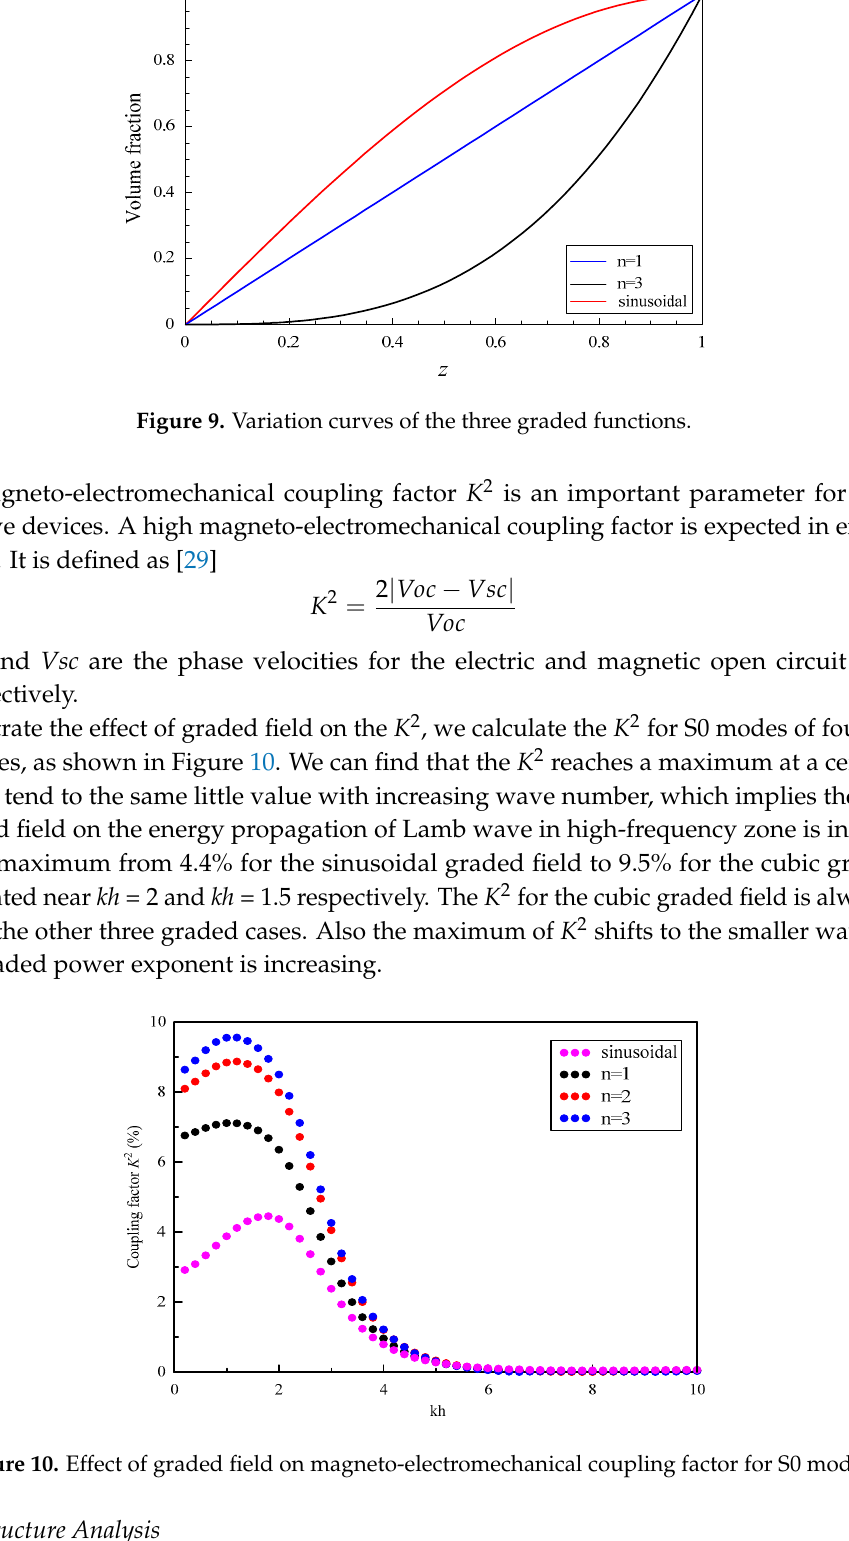
fields; ( a ) Frequency spectra; ( b ) Phase velocity spectra.